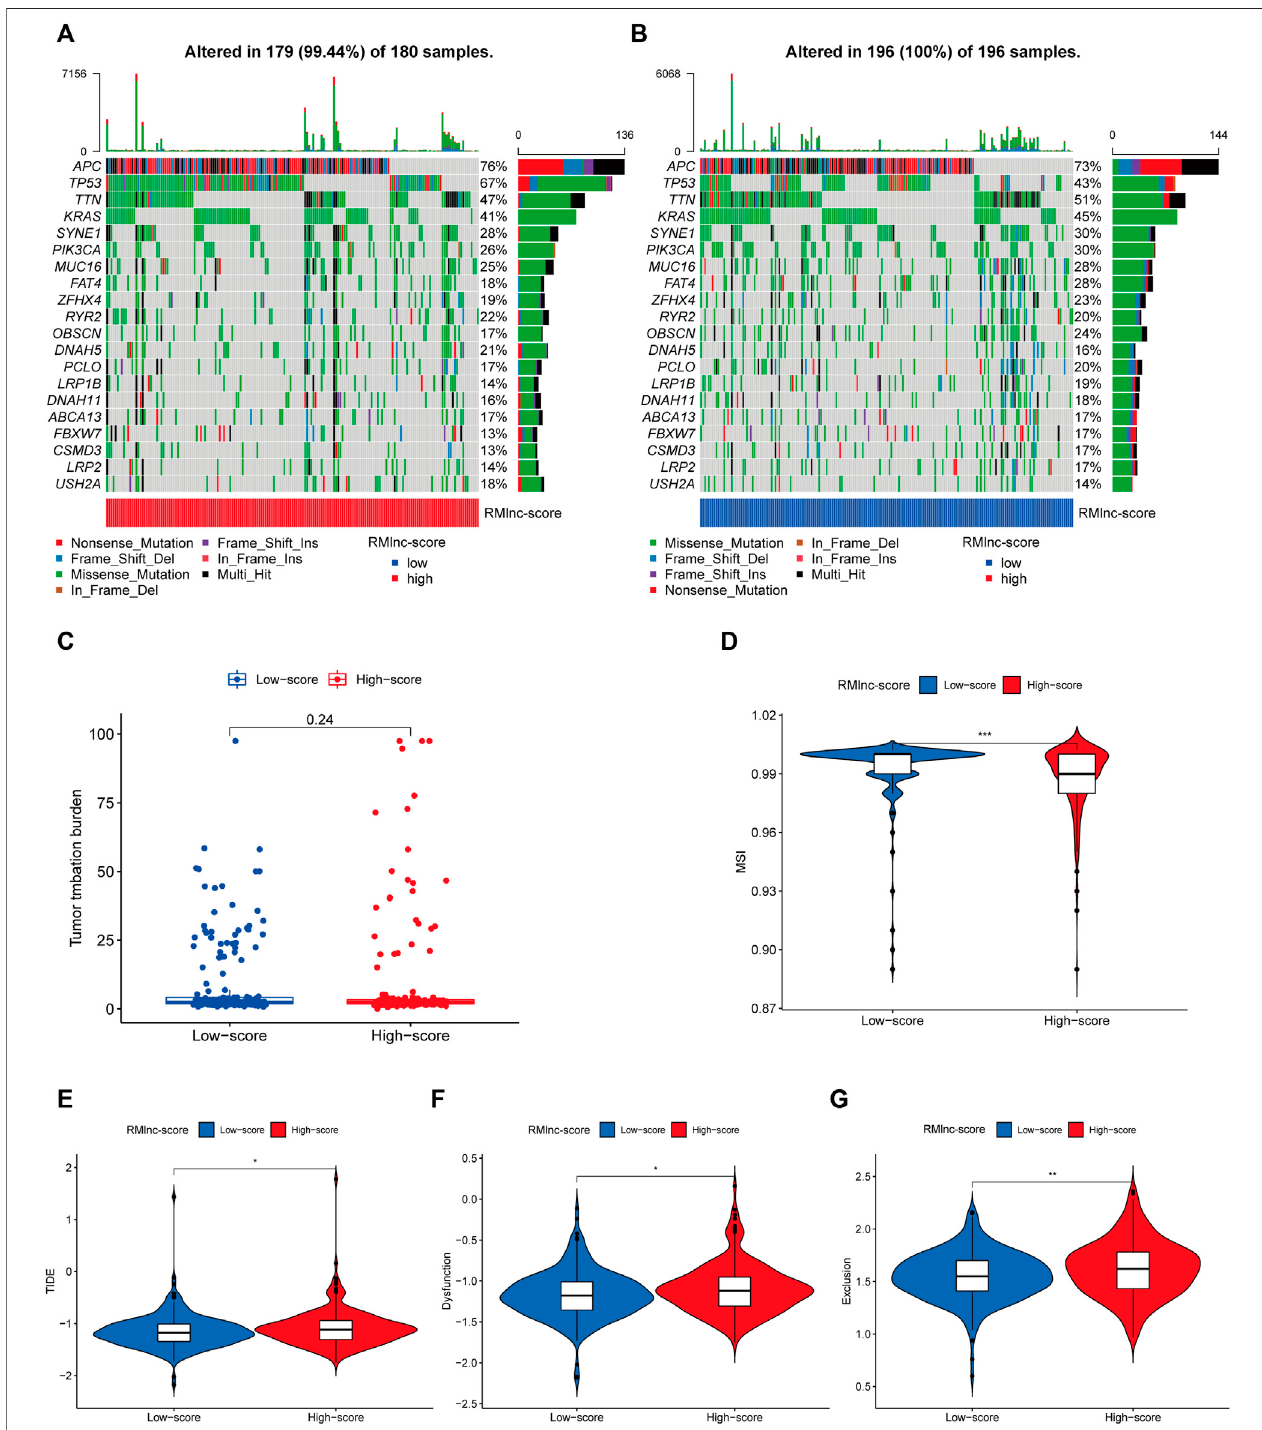
FIGURE11| Predictabilityofimmunotherapyresponseintheprognosticsignature. (A,B) Waterfallplotofthetumormutationalburden(TMB)landscapeinthehigh RMlnc-score and low RMlnc-score groups presenting the top 20 genes with the highest mutation frequency. (C) Differences in TMB of colon cancer patients in the high andlowRMlnc-scoregroups. (D) Differencesinmicrosatelliteinstability(MSI)ofcoloncancerpatientsinhighandlowRMlnc-scoregroups. (E-G) TIDEpredictionscores (including TIDE score, dysfunction score, and exclusion score) between high RMlnc-score and low RMlnc-score groups. *p < 0.05; **p < 0.01.